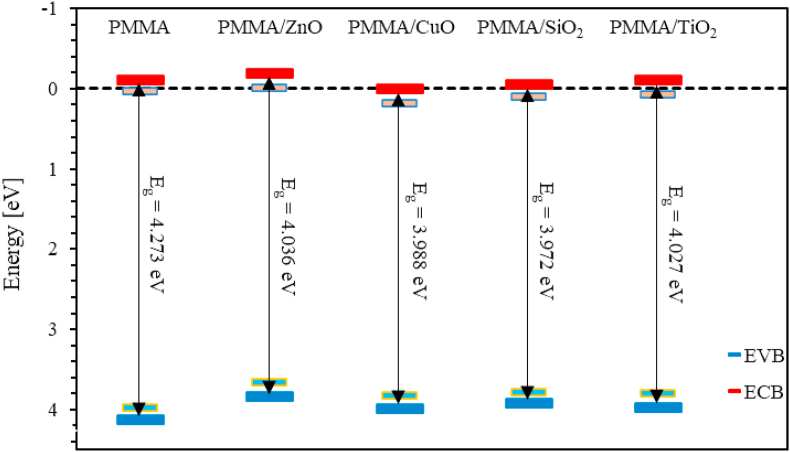
Schematic diagrams of band structures of PMMA and PMMA incorporated with ZnO, CuO, SiO2 and TiO2 NPs nanocomposites thin films.